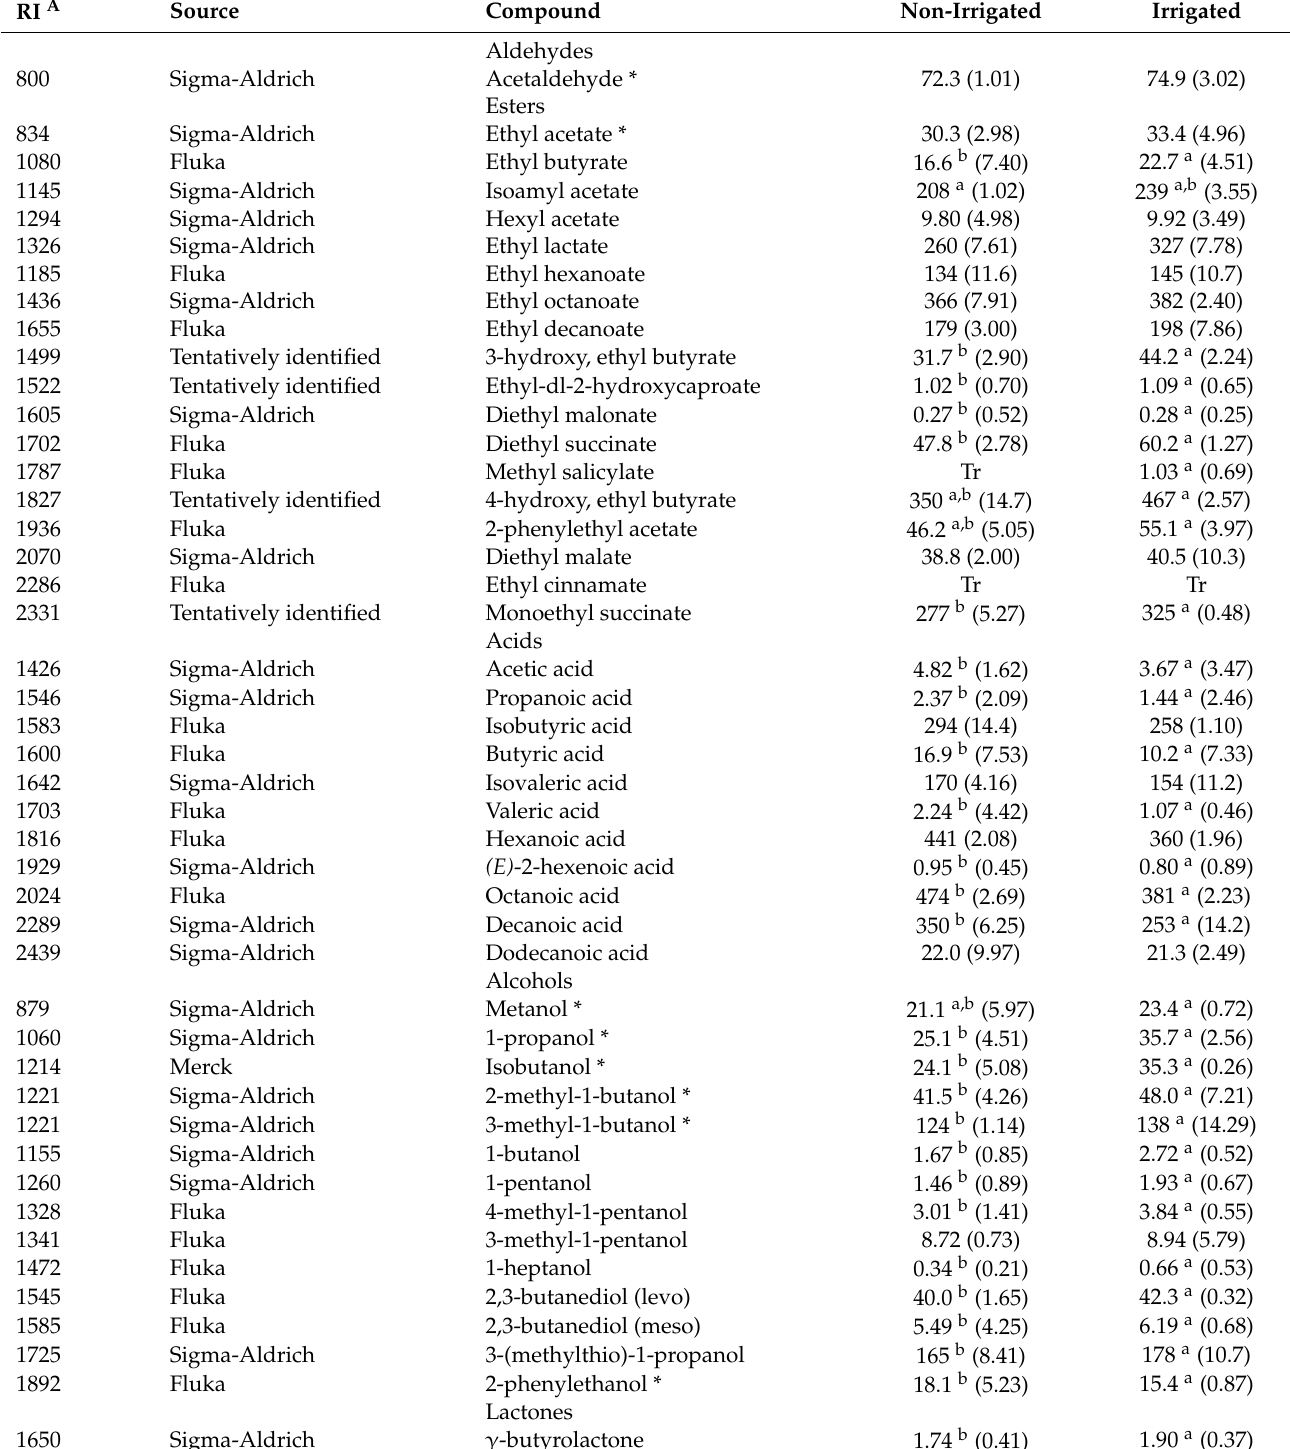
Table 3. Mean concentrations ( µ g/L) and relative standard deviations ( n = 4) of volatile compounds formed principally during alcoholic fermentation of Chelva wines made with grapes from irrigated and non-irrigated